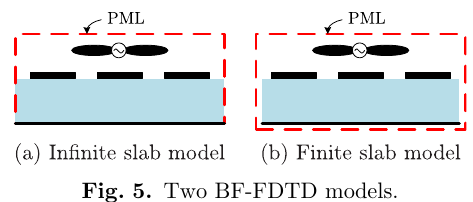
Fig. 5. Two BF-FDTD models.